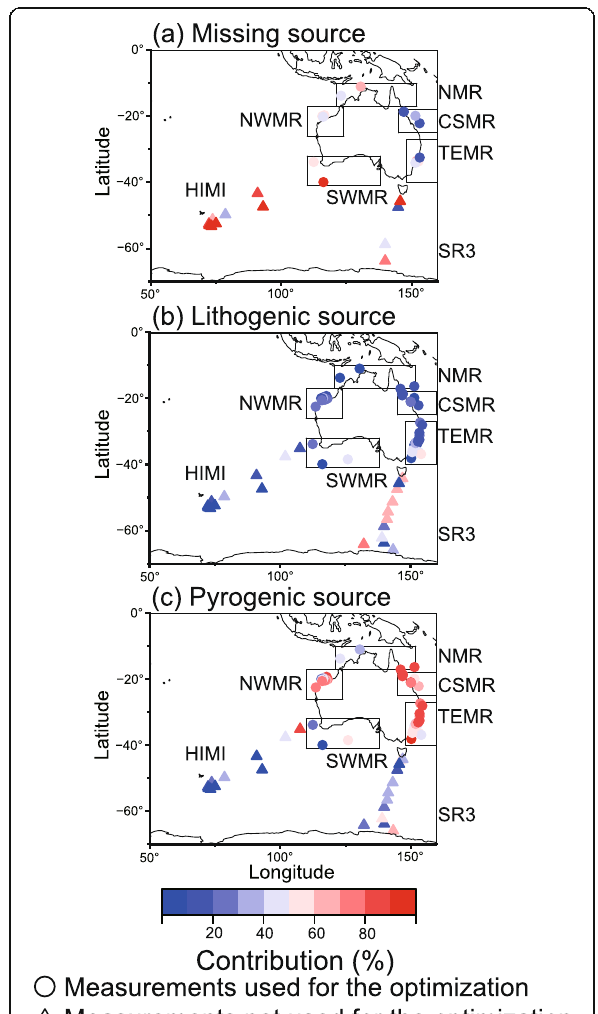
Fig. 9 Variability in the a posteriori model contribution of a missing source, b lithogenic source, and c pyrogenic source to L Fe concentration in aerosols